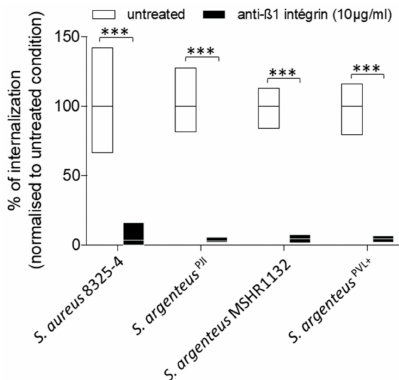
Figure 3. The internalization of S. argenteus strains into MG-63 cells requires β 1 integrin. A pre-treatment of MG63 cells with a blocking anti- β 1 integrin antibody inhibits more than 90% of S. aureus and S. argenteus strains internalization. Mann–Whitney test was performed for statistical analysis. *** means p < 0.001.